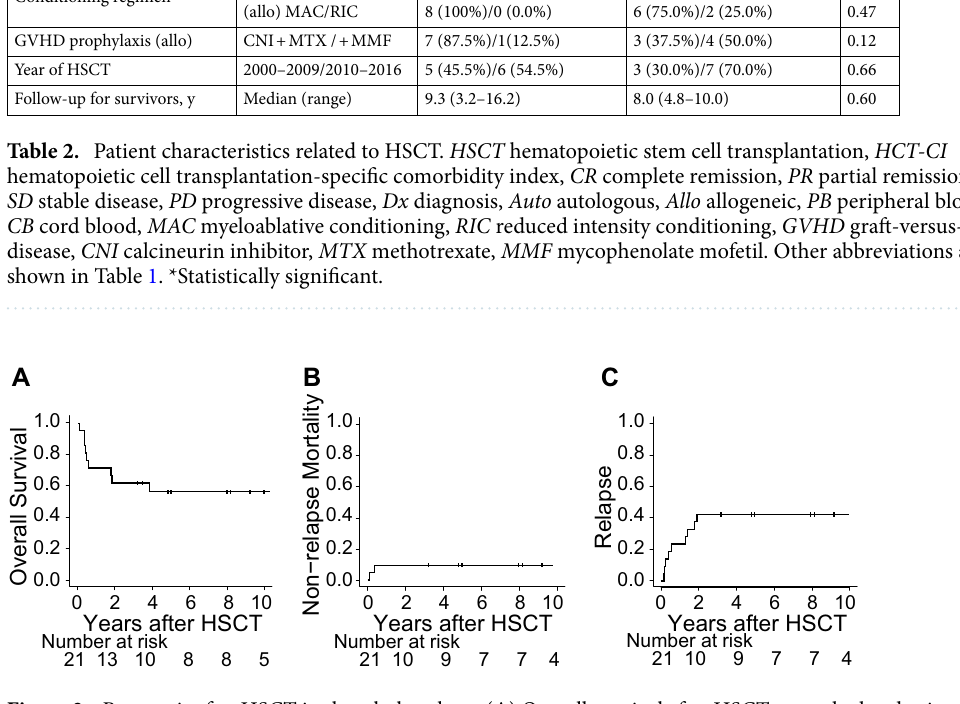
Figure 2. Prognosis after HSCT in the whole cohort. ( A ) Overall survival after HSCT was calculated using the Kaplan–Meier method. ( B ) Non-relapse mortality is shown treating relapse as a competing risk. ( C ) The cumulative incidence of relapse was calculated treating death without relapse as a competing